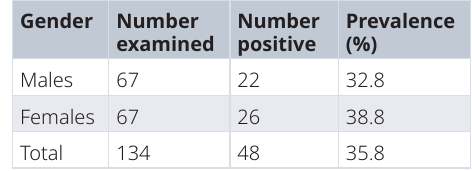
Table 1. Prevalence of intestinal parasites among gender.